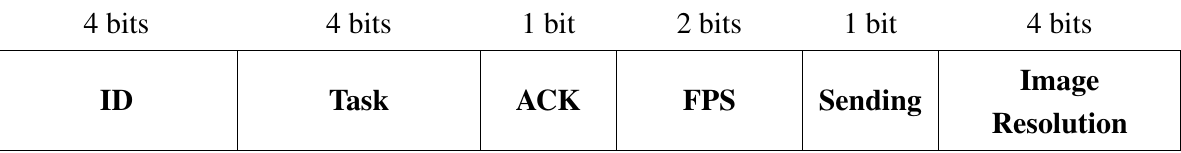
Figure 5. System data block